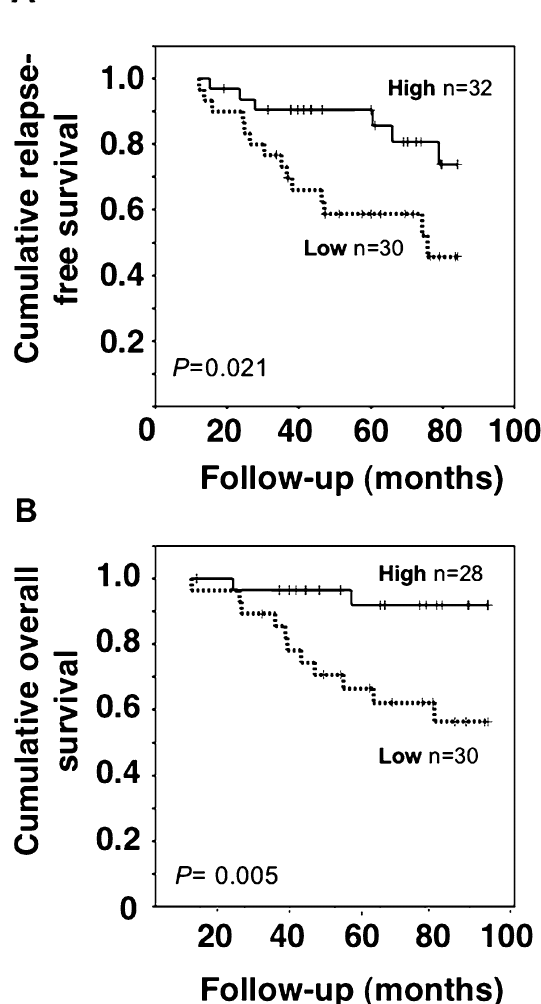
Fig. 4. XBP-1 mRNA expression and outcome. Kaplan–Meier plots are shown for breast cancer relapse-free (A) and overall survival (B) in a cohort of postmenopausal women with ER α -positive, pri- mary breast cancer, receiving adjuvant tamoxifen with up to 7 years follow-up. XBP-1 quantitative RT-PCR amounts were dichotomised for outcome analysis by applying Receiver Operating Characteristic plots (see text) for breast cancer relapse and breast cancer survival at 5 years after surgery; cut-off 0.2 attomoles/µg total RNA. Unbroken lines represent cases with high levels of XBP-1, dotted lines repre- sent cases with low levels of XBP-1. In all cases crosses represent censored data and p -values are given for log-rank